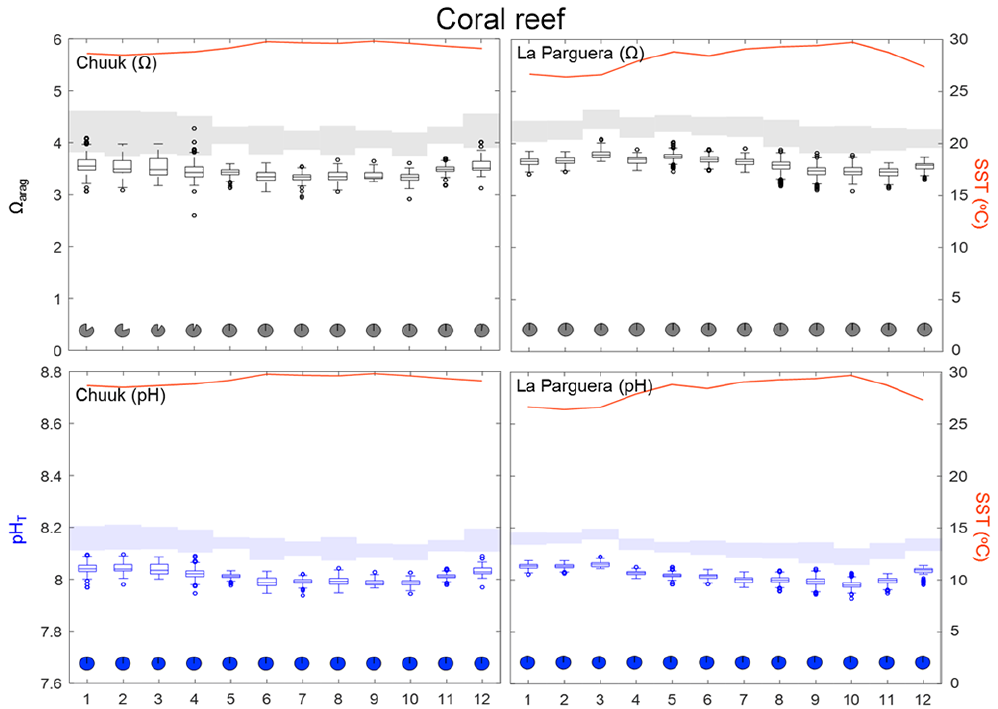
Figure 7. Box and whisker plots of present-day monthly surface seawater (cid:127) arag (top) and pH (bottom) and monthly mean SST in coral reef ecosystems within a semi-closed atoll lagoon in Micronesia (Chuuk) and a patch reef in the Caribbean Sea southwest of Puerto Rico (La Parguera). See detailed description of figure components in Fig. 2